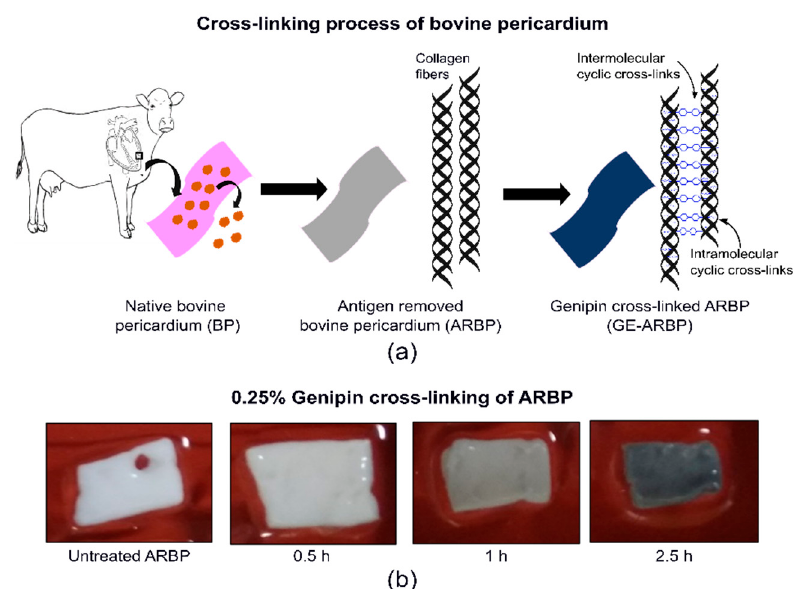
Figure 6. ( a ) Schematic of the pre-processing of the bovine pericardium and subsequent cross-linking with genipin. ( b ) Photographs of genipin cross-linked bovine pericardium at different time points. Genipin (GE) Cross-Linking of ARBP